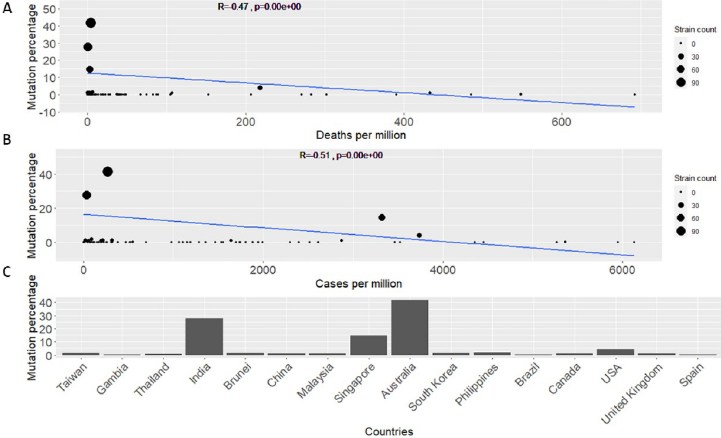
Fig 2. Analyses plots for N protein mutation at position 28311 (P13L). A. Regression model line showing the simplified fit for mutations percentage across countries and the deaths per million for each country. Pearson’s correlation is shown by the R value accompanied by the p -value of the correlation coefficient. B. Similar regression fit for mutations percentage across countries this time showing cases per million for each country. Pearson’s correlation is shown by the R value accompanied by the p -value of the correlation coefficient. C. Detailed histogram of the percentage occurrence of the mutation across different countries. These values make up the “percent” predictor variable utilized in our model (see Materials and Methods). Countries are sorted with increasing deaths per